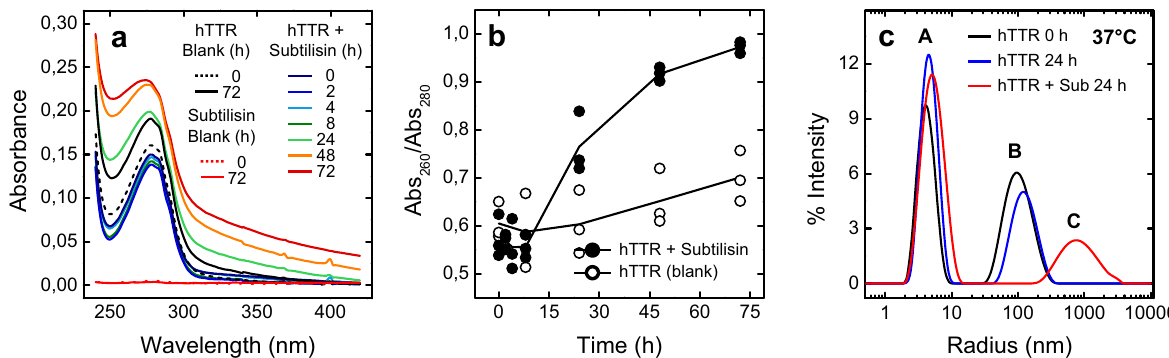
Fig. 4 Time-course analysis of hTTR aggregation induced by subtilisin. hTTR (1 mg/ml) was treated at 37 °C with subtilisin in TBS buffer, pH 7.4, containing 5 mM CaCl 2 at an enzyme:hTTR ratio of 1:20 (mol/mol). At time points, aliquots (50 µ l) of the proteolysis reaction were withdrawn, diluted ten- fold with the same buffer and analysed by UV – Vis absorption spectroscopy and DLS. a UV – Vis absorption spectra of the proteolysis reaction of hTTR with subtilisin at increasing reaction time. Blank measurements with hTTR and subtilisin alone are also shown. b Plot of the Abs 260 /Abs 280 ratio vs. time of a hTTR solution (0.1 mg/ml) in the presence (black circles) and absence (white circles) of subtilisin. The data points result from three different experiments. c DLS analysis of hTTR proteolysis by subtilisin after 24-h reaction. DLS traces of hTTR alone, after 0 or 24-h incubation are shown as controls. DLS data are reported as % intensity size distribution. For each trace, the values of R h , %mass distribution and %PD of the oligomeric/polymeric species A, B, and C are reported in the Supplementary Table 1.